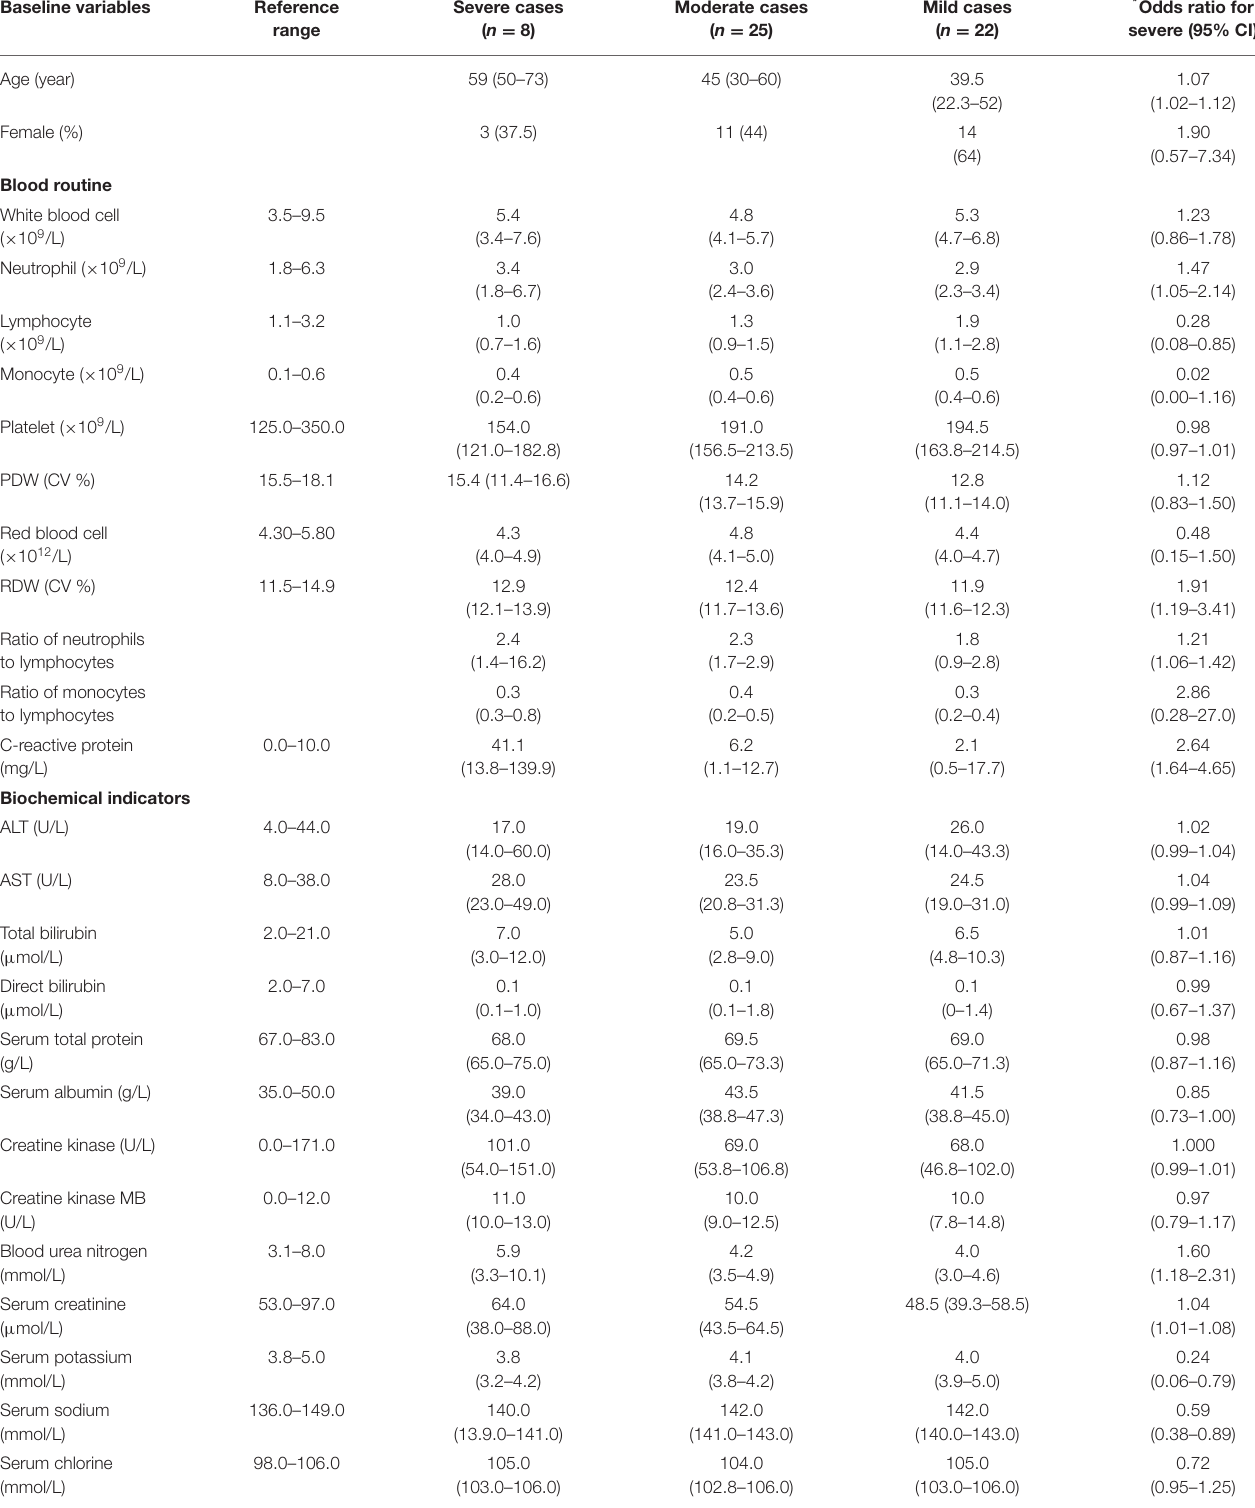
TABLE 2 | Laboratory parameters of mild, moderate, and severe COVID-19